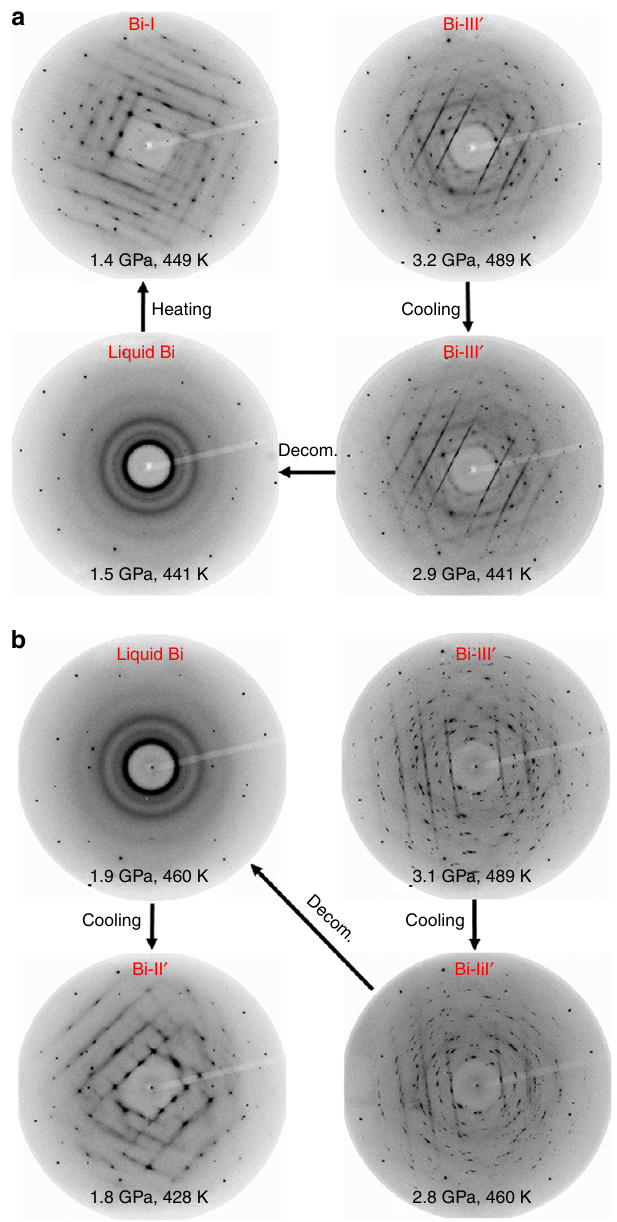
Figure 3 | Crystallization of the decompression-induced liquid under heating and cooling. ( a ) Bi-III 0 is obtained by compressing the DIL at 489K. The Bi-III 0 then melts into a liquid state under decompression (decom.). The DIL later crystallizes into Bi-I at 449K upon heating at 1.5GPa. After crystallization, the pressure changes from 1.5 to 1.4GPa. ( b ) The DIL at 1.9GPa crystallizes into Bi-II under cooling at 428K. The pressure changes from 1.9 to 1.8GPa after